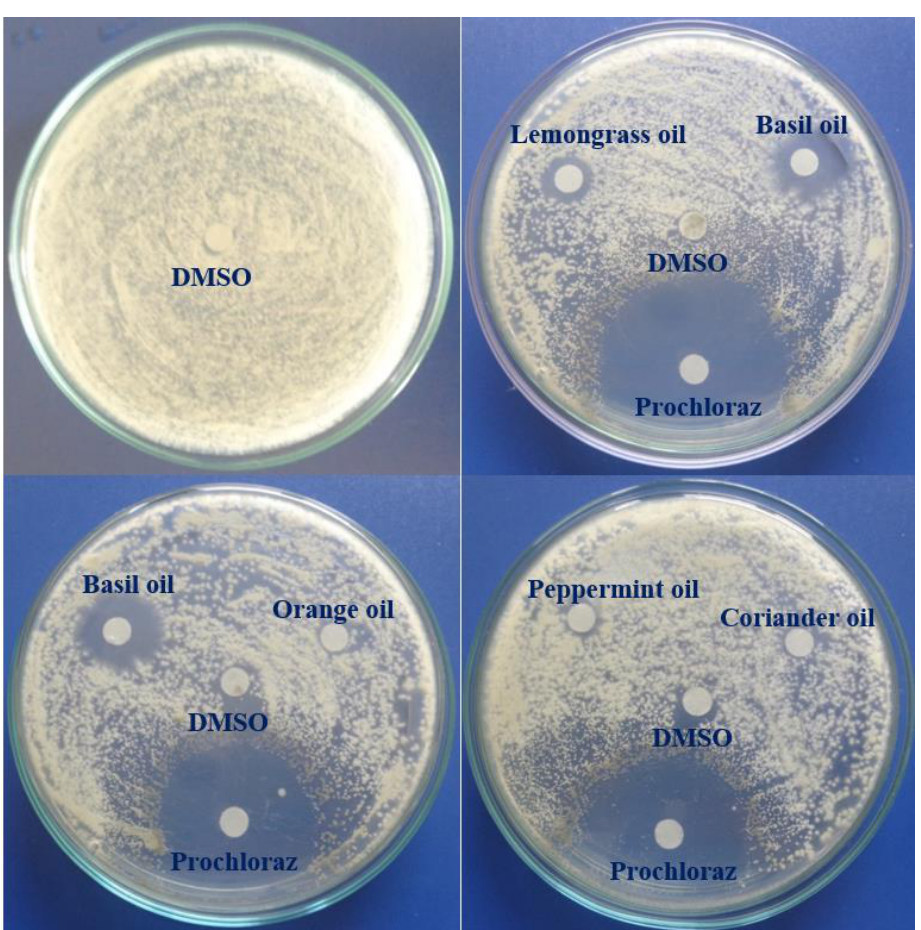
Figure 3. The antifungal activity of EOs, dimethyl sulfoxide (DMSO), and fungicide (prochloraz) against the mycelial growth of C. acutatum at 4 days after innoculation.